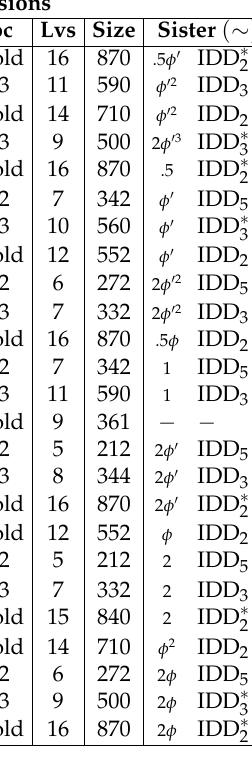
Table 2. The 55 admissible point arrays [1,2], grouped by extension vectors (cid:126) T 5 , (cid:126) T 3 and (cid:126) T 2 , ordered from largest to smallest relative radii. The initial scaling of the base point arrays before affine extension is as shown. The gauge points and their location on the great circles are listed (Figure 1). The number of distinct radial levels, size of the full point array (cardinality) and sister point arrays are also given (3 arrays do not have sister arrays). While all sister arrays have identical point clouds, the two point arrays which are identical are indicated with †. The 14 point arrays with only a single radial level located on the icosahedral symmetry axes are indicated with an asterisk *. Three point arrays ICO 5 , DOD 3 and IDD 2 have an element at the origin, which is degenerate. Note that φ (cid:48) = − 1/ φ ; however all of the base polyhedra are invariant under multiplication by − 1, therefore we only report the absolute value of the